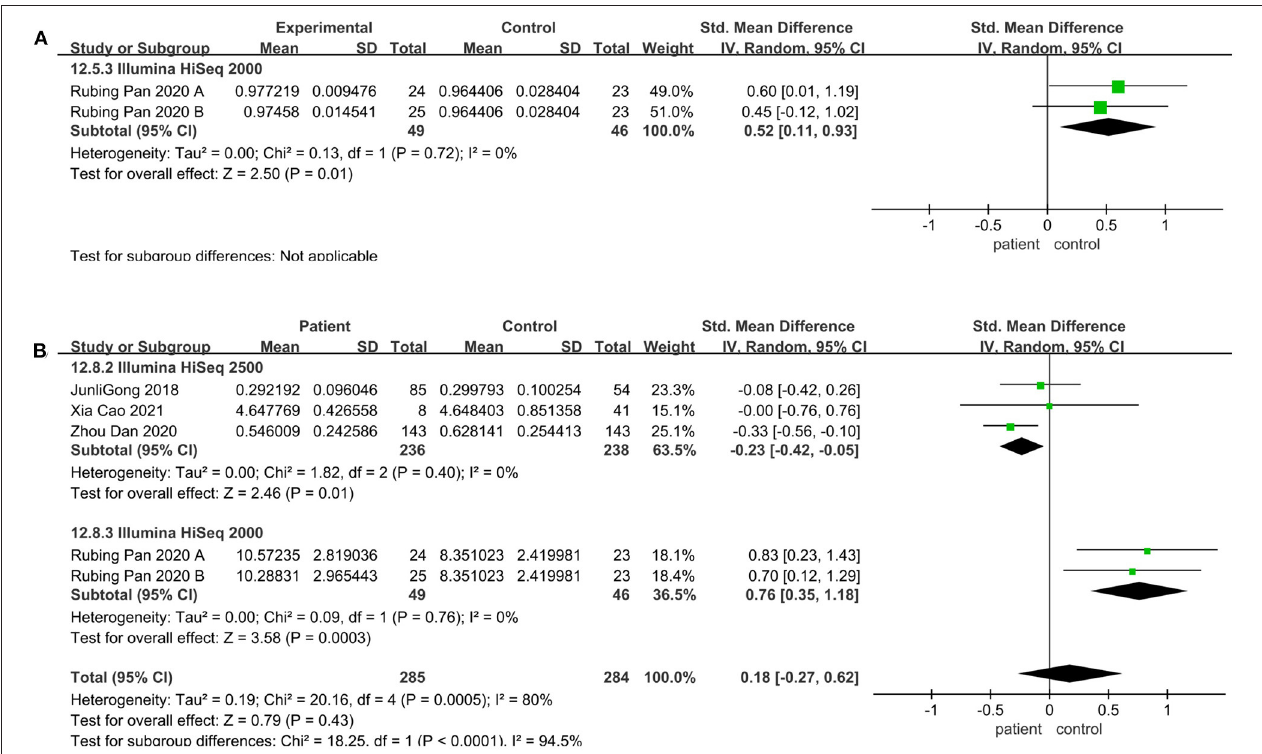
FIGURE 6 | Evenness meta-analyses for the sequencing instrument. Forest plot for the Simpson (A) , and PD (B) . SMD, standardized mean difference; SD, standard deviation.